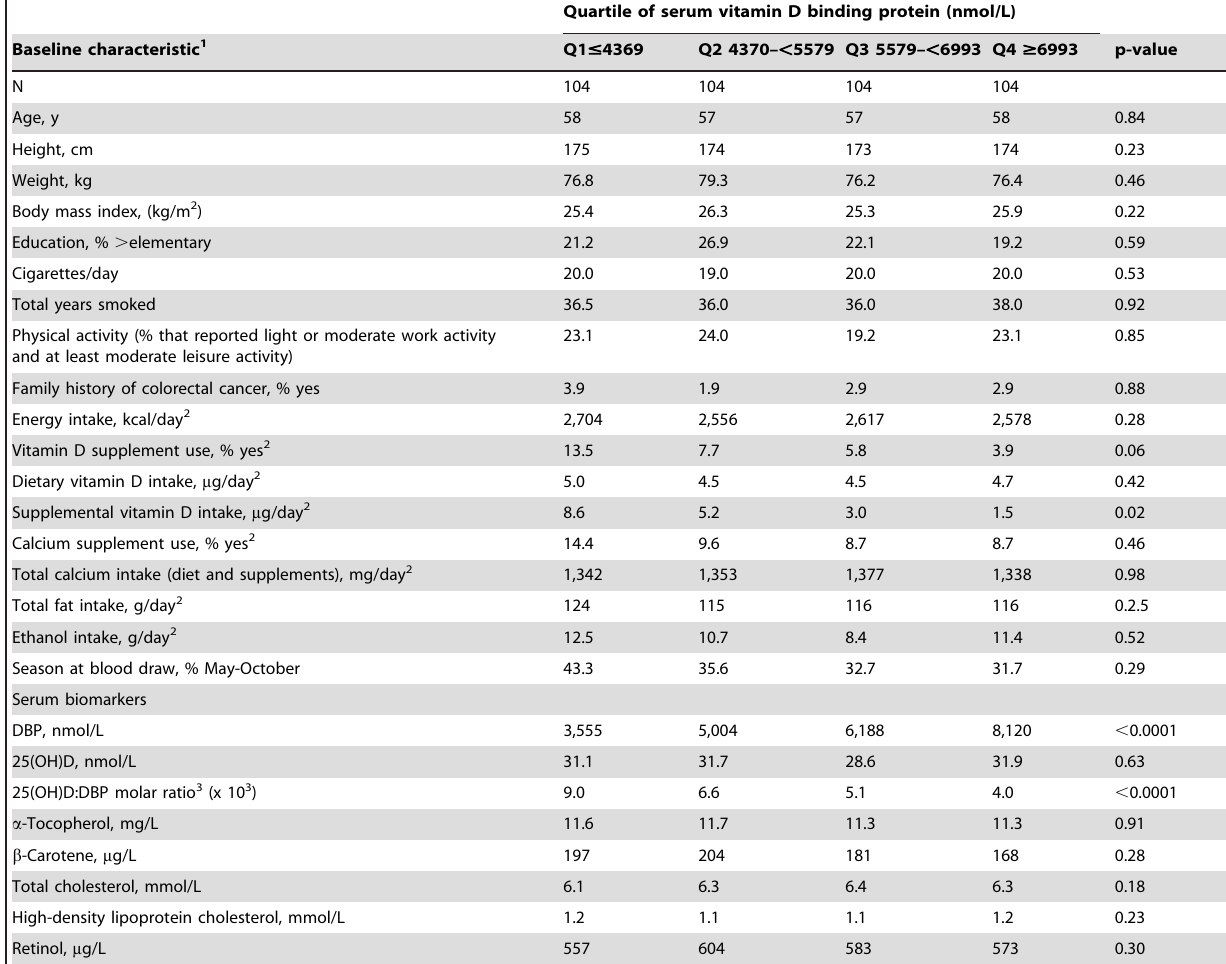
Quartile of serum vitamin D binding protein